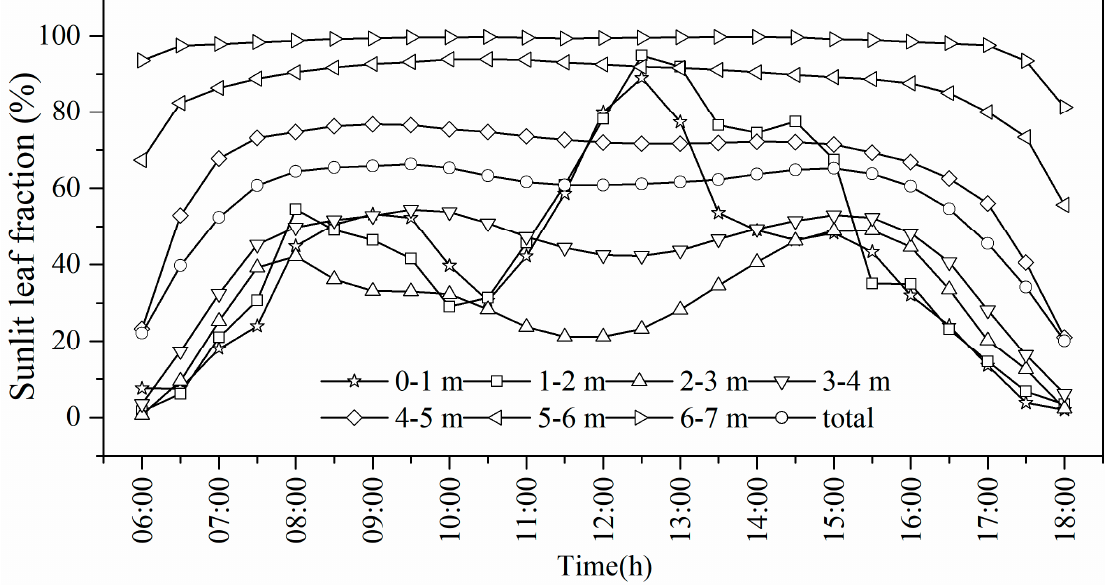
Figure 7. The temporal variations of sunlit leaf fractions at different horizontal layers during a daily sun course in a forest stand.